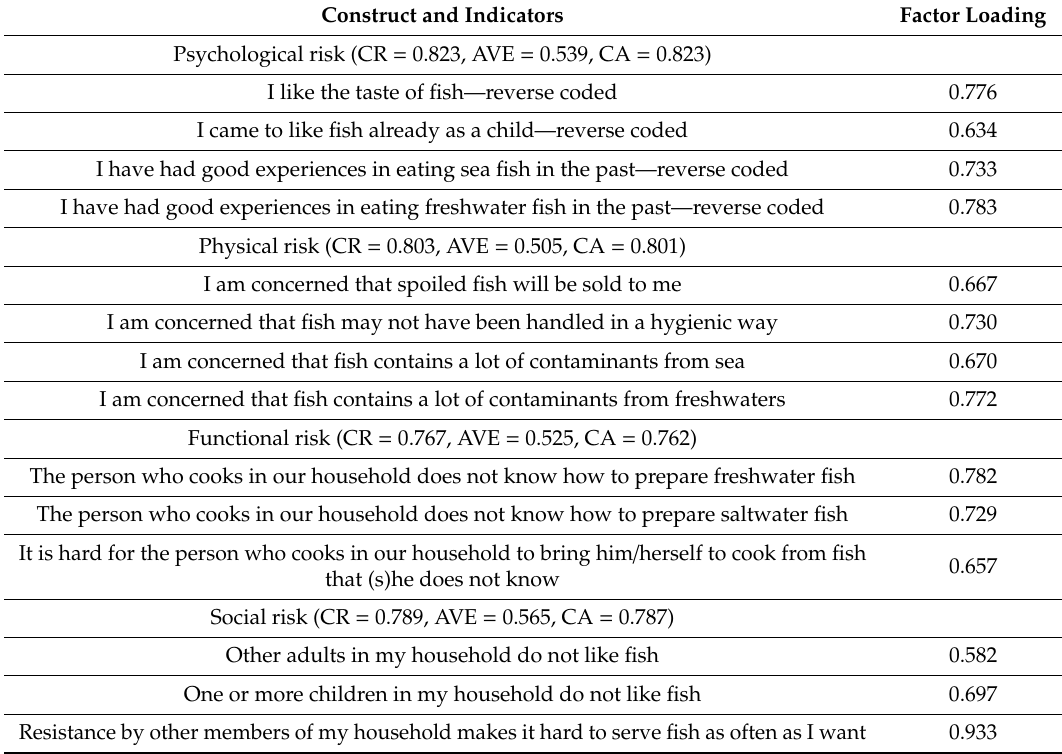
Table 4. Construct reliability and validity.